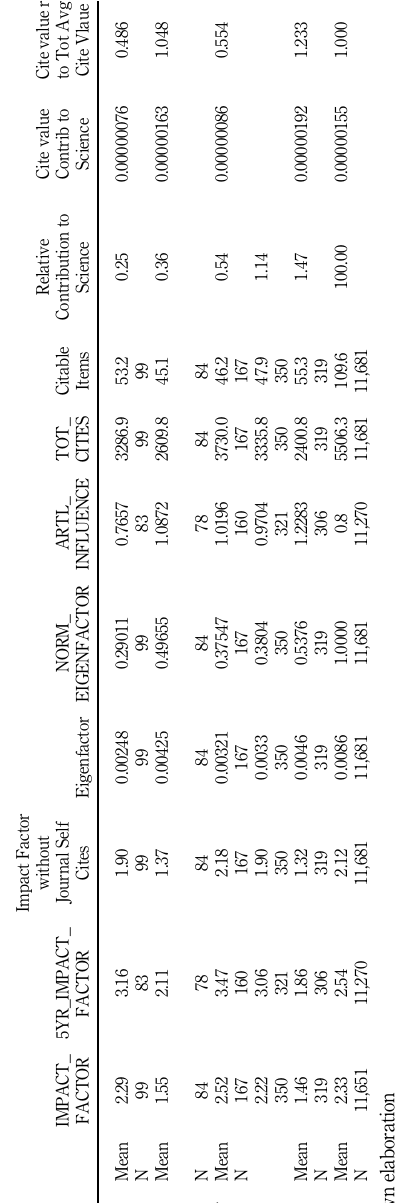
Table 3. Journal impact metrics and relative values by